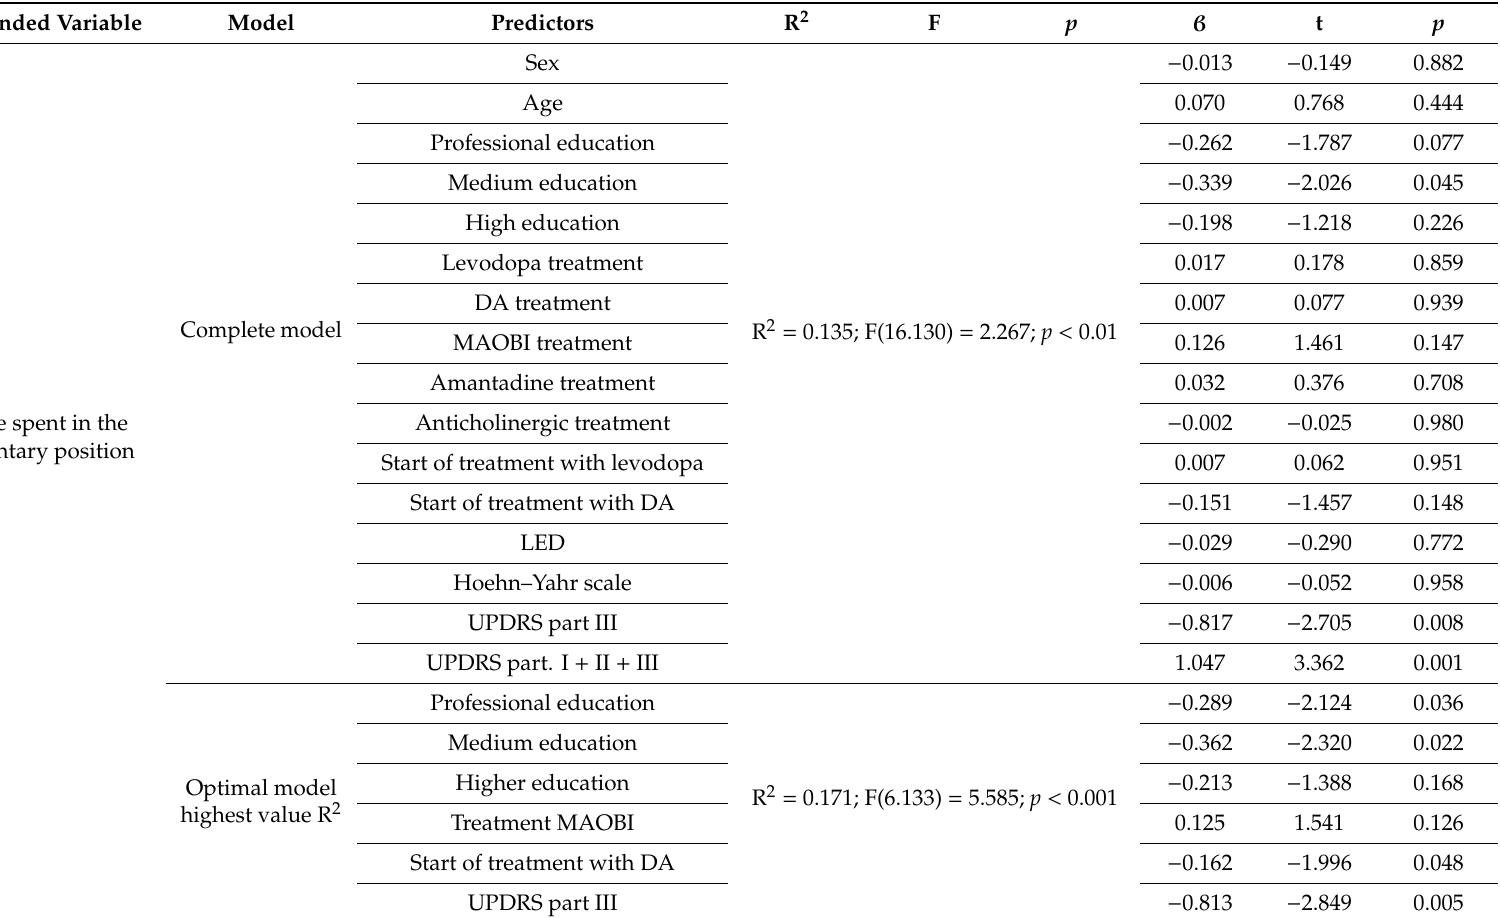
Table 4. Analysis of backward regression, which determines % of variability of time spent in the sedentary position conditioned by the group of socio-demographic Table 3. Analysis of backward regression, which determines % of the variability of ITMWA, conditioned by the group of socio-demographic and clinical predictors and clinical predictors in the group of patients with Parkinson’s disease. in the group of patients with Parkinson’s disease.